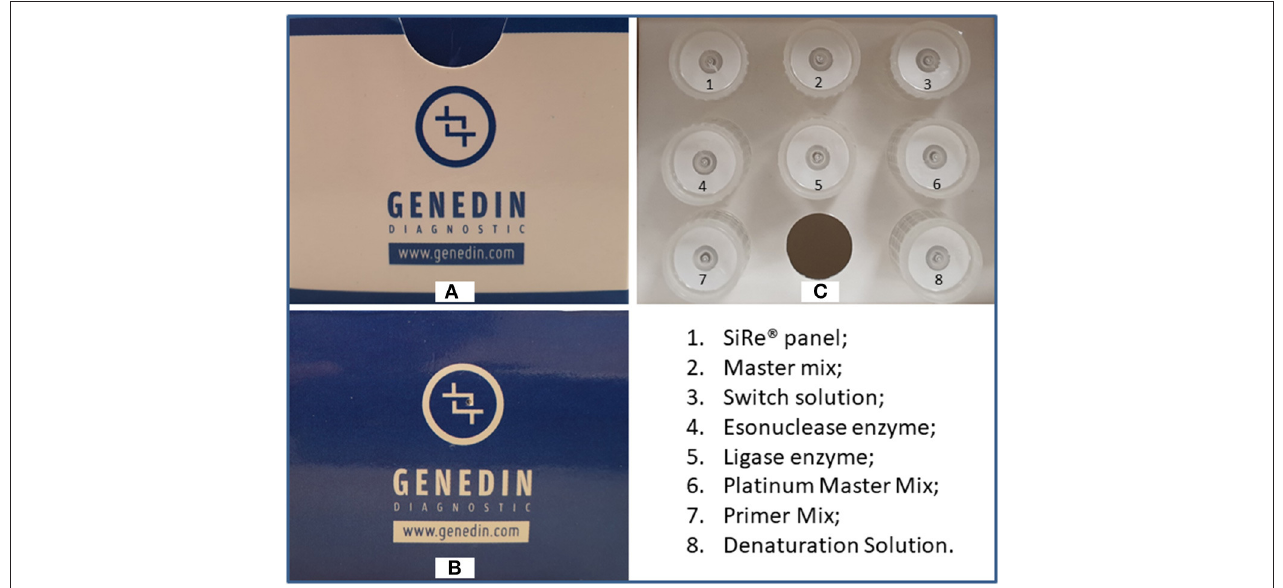
FIGURE 1 | Upper (A) and frontal (B) parts of the SiRe ® kit box and the related reagent tubes distributed in the internal (C) part. Permission to publish the figure was obtained by Genedin s.r.l. (a spin-off of the Department of Public Health, University of Naples Federico II).